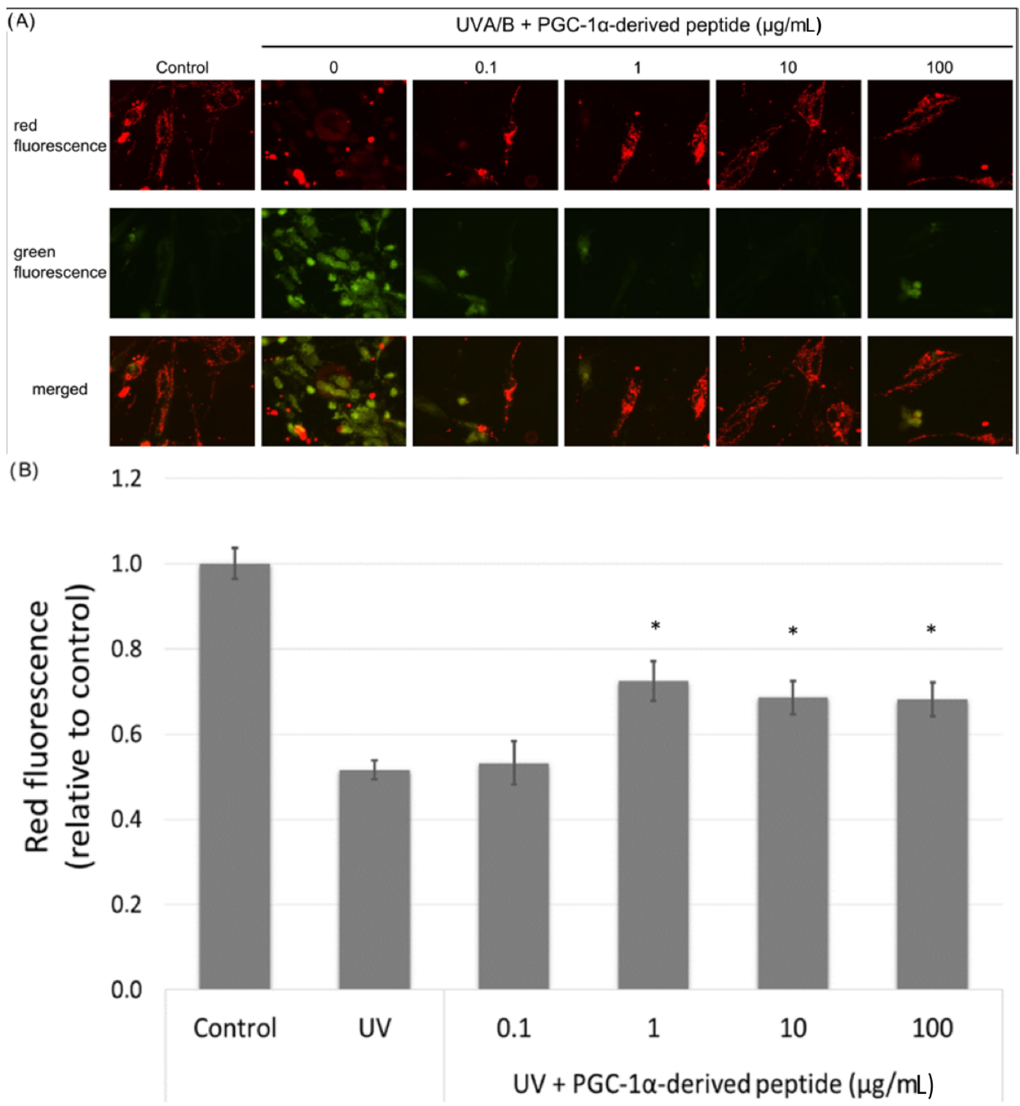
Figure 5. Mitochondrial membrane potential in NHDF cells. Cultured cells were irradiated with UVA/B at a dose of 0.15 J/cm 2 and then treated with the PGC-1 α -derived peptide at various concentrations for 24 h. The mitochondrial membrane potential was determined using JC-1 dye with a fluorescence microscope ( A ) and a fluorescence reader ( B ). The values represent means ± SEM of at least 3 independent experiments (* p < 0.05 compared with UV irradiated group).